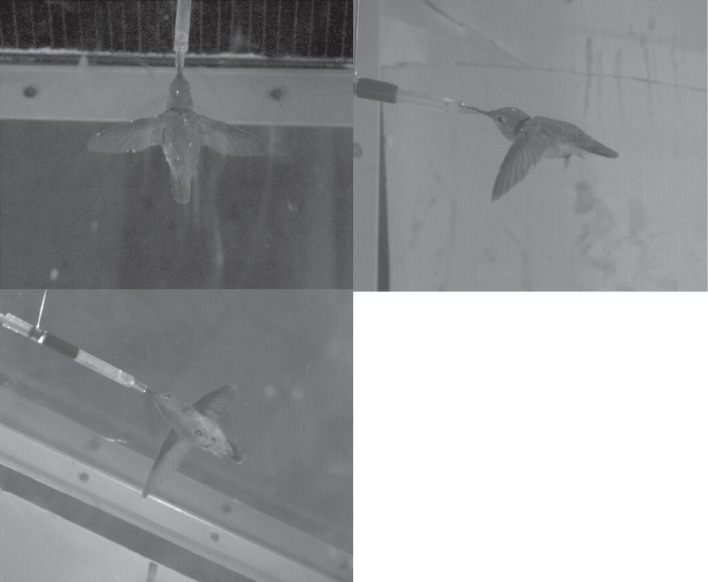
Camera views of the hummingbird flying in the wind tunnel.